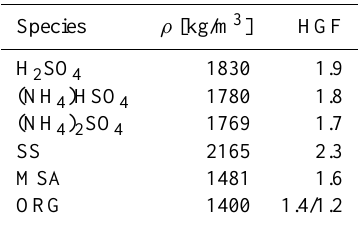
Table 7. Density and HGF values used for different species to estimate their contribution to the measured 90nm HGF values in Fig. 14. Species ρ [kg/m 3 ] HGF H 2 SO 4 1830